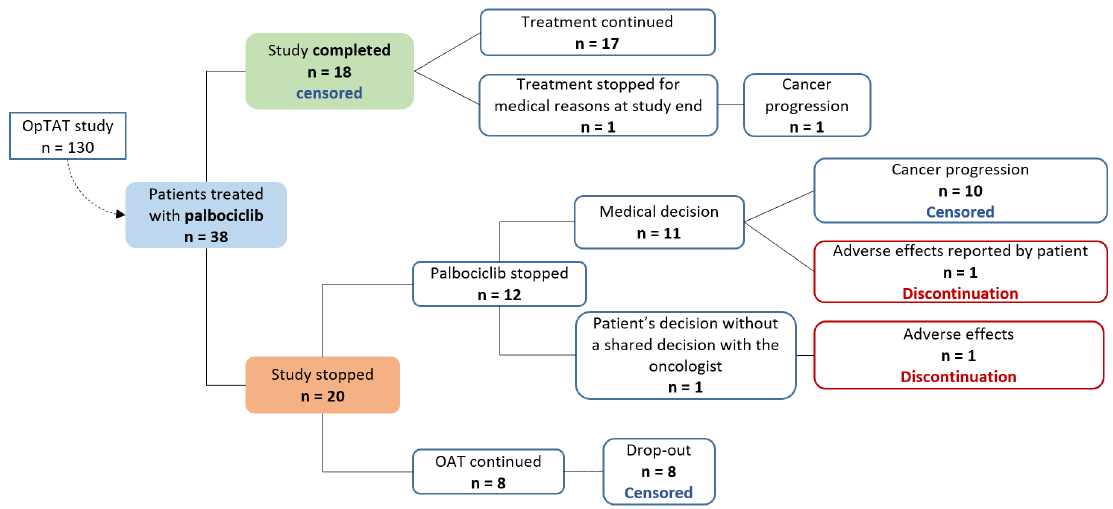
Figure 3. Discontinuation and censoring times algorithm.